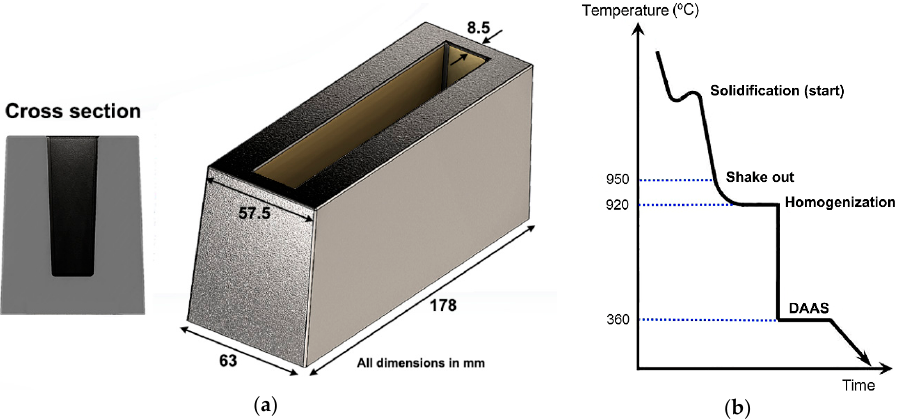
Figure 1. ( a ) Schematic of the cast component; and, ( b ) the Direct Austempering After Solidification (DAAS) treatment procedure.